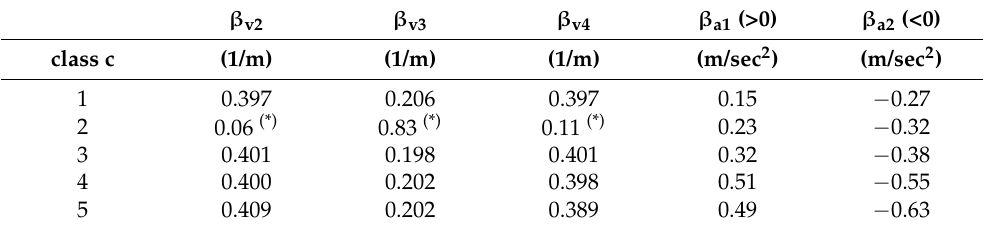
Table 3. Updated parameters of vector β for each link class c.